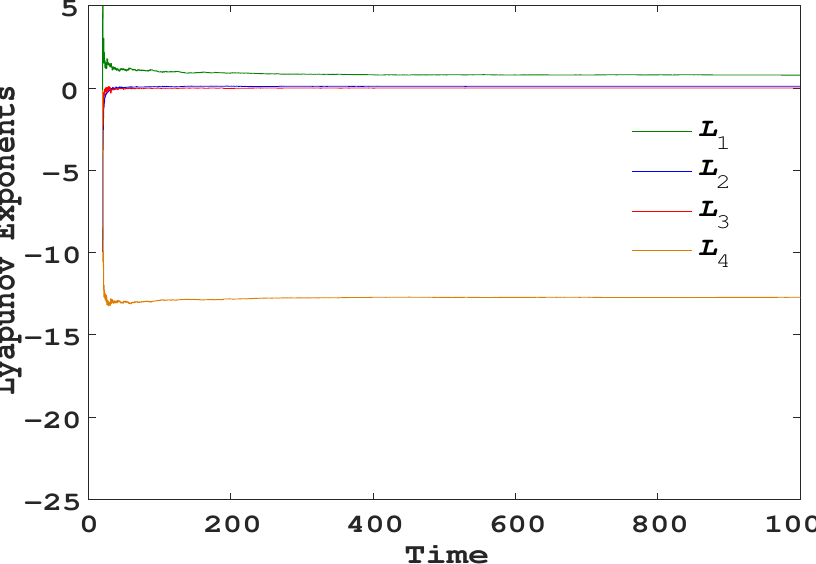
Figure 2. Four Lyapunov exponents of system (2) for ( a , b , c , k , m ) = ( 10,100,2.7, − 0.2,1 )